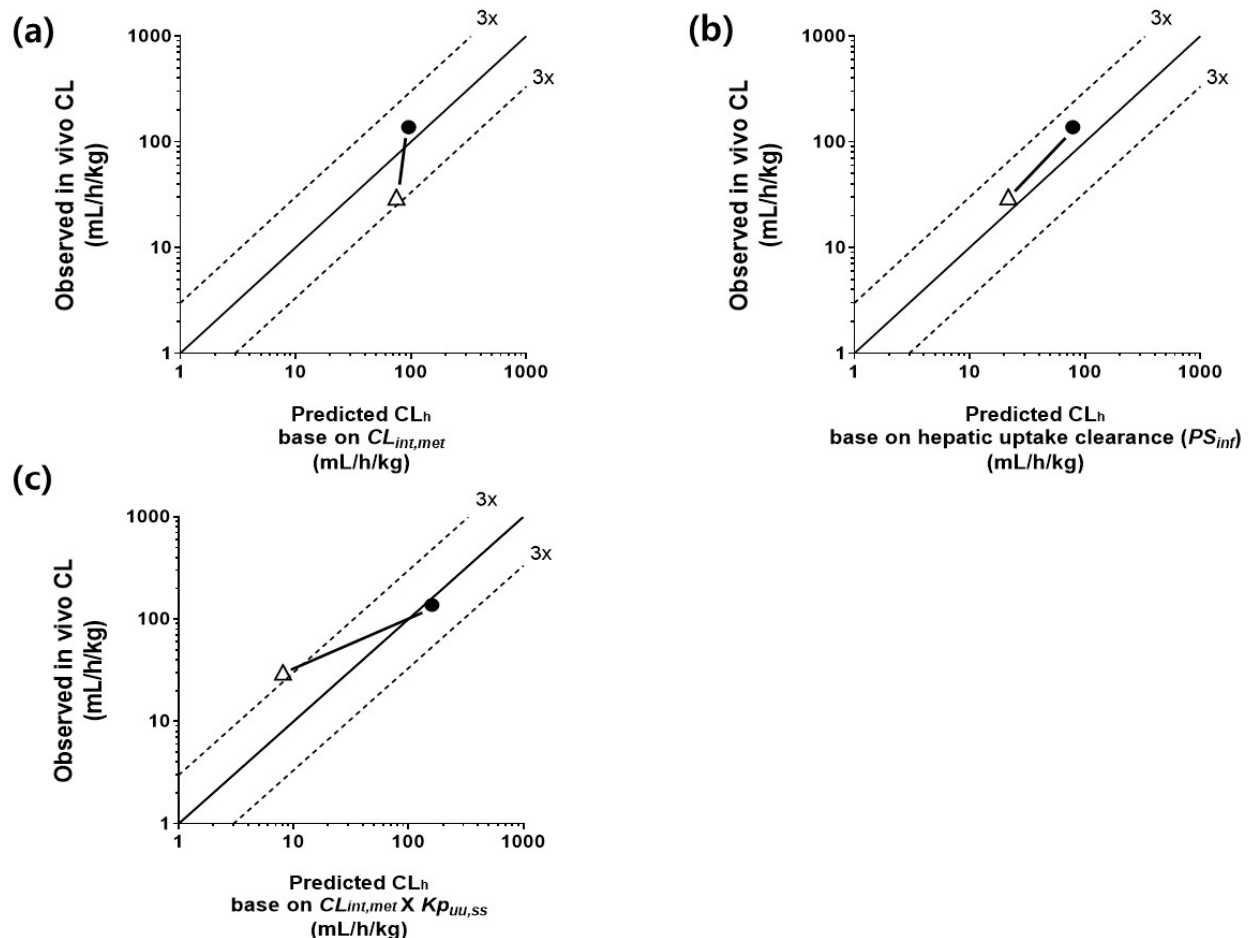
Figure 6. In vitro predicted hepatic clearance correlation with the observed hepatic clearance in the control (open triangle) and repeated-dosing (closed circle) groups. ( a ) Method 1: Predicted hepatic clearance based on the intrinsic metabolic clearance ( CL int,met ). ( b ) Method 2: Predicted hepatic clearance based on the hepatic uptake clearance ( PS inf ). ( c ) Method 3: Predicted hepatic clearance based on the corrected CL int,met by multiplying with Kp uu,ss . The solid lines represent the line of unity, which is the best fit, and the dashed lines represent the 3-fold error from the unity.